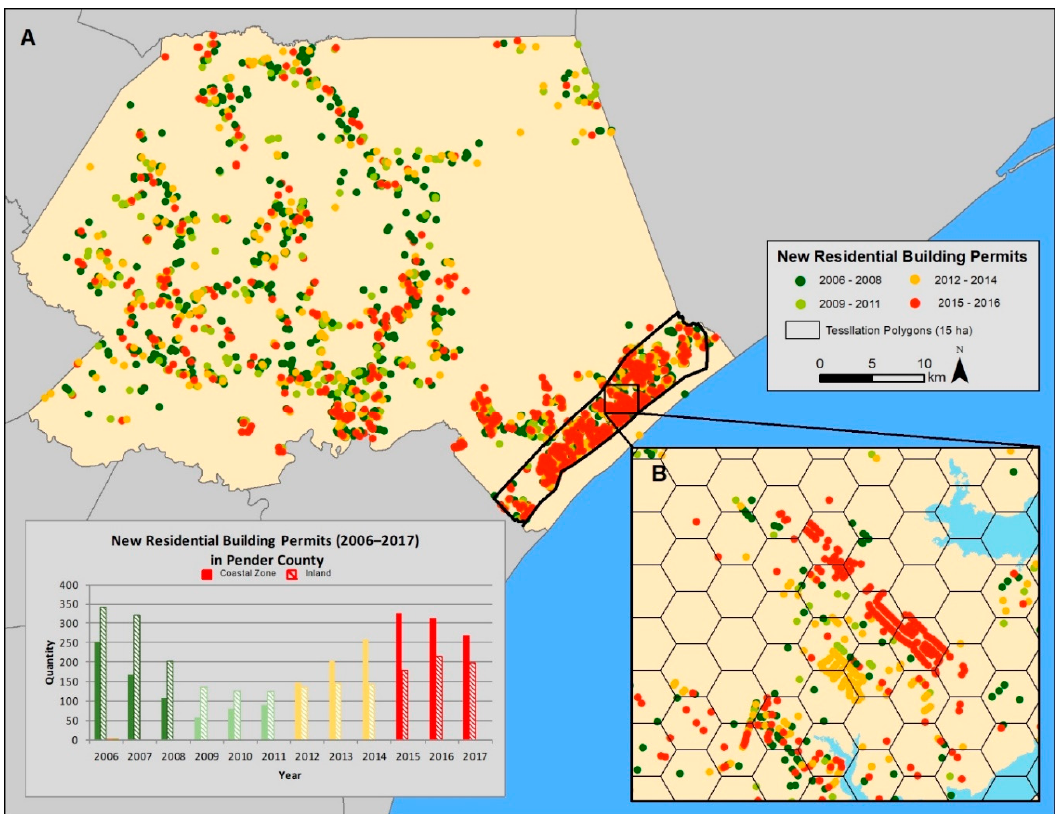
Figure 10. Locations of residential building permits from 2006 through 2017 (A) and a closer view of the permits in the urbanizing coastal area (B).